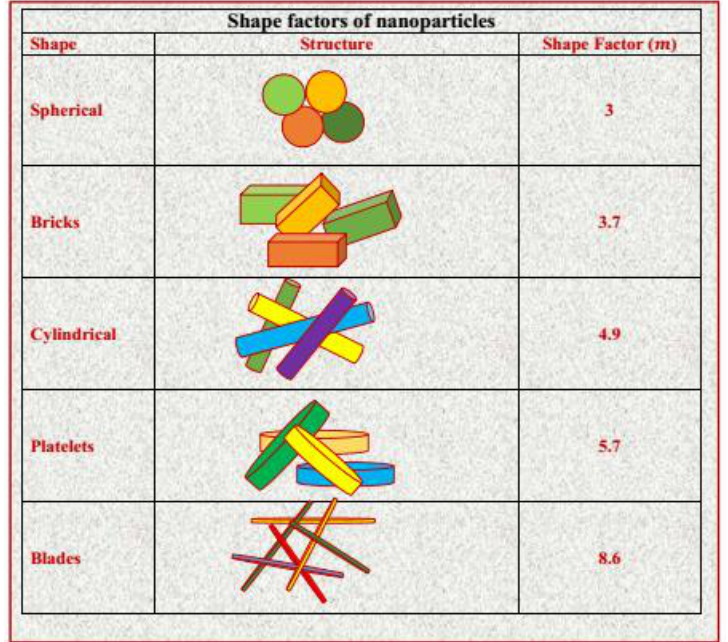
Figure 2. Shape factors of the nanoparticles.